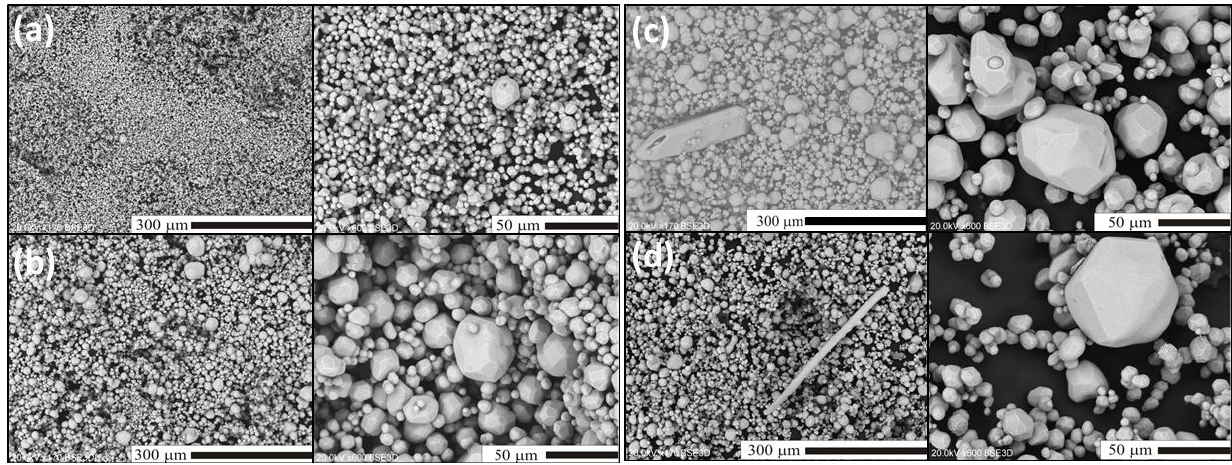
Figure 5. SEM images of Lu 2 O 3 of samples of Series III. ( a ) SIII-1; ( b ) SIII-2; ( c ) SIII-3; ( d ) SIII-4. Note that some grans in SIII-3 and SIII-4 powders have the unexpected shape of needles.